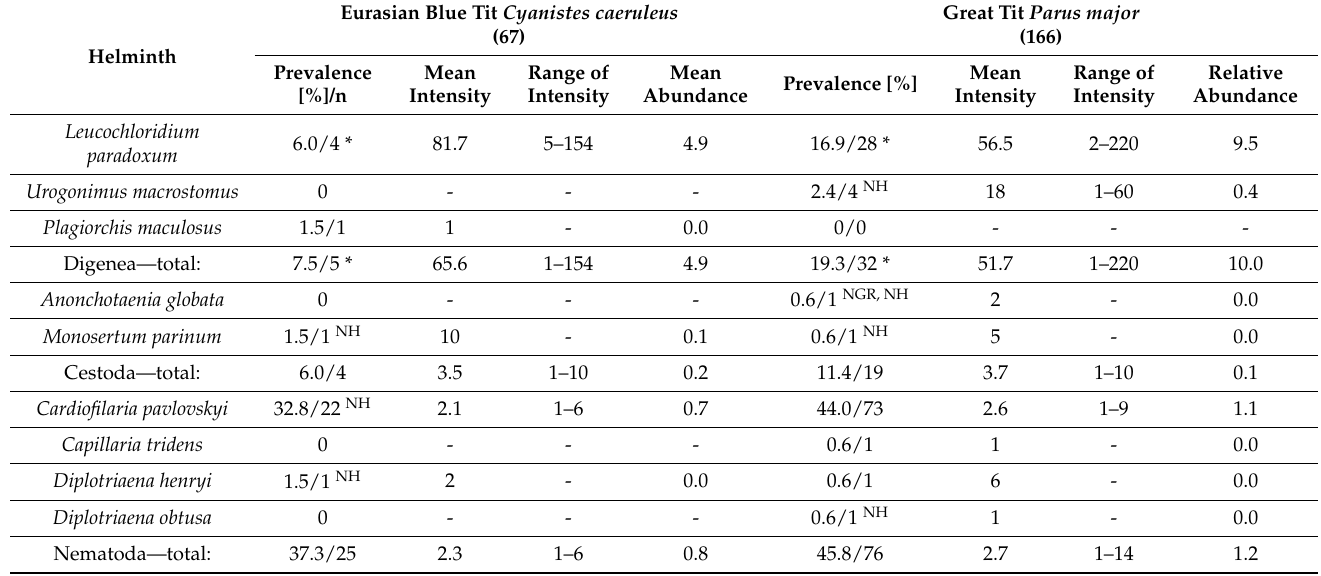
Table 1. Parasitological indicators of helminths in Eurasian blue tit and Great tit during autumn migration on the southern coast of the Baltic Sea, northern Poland, 2008–2012. Numbers of examined birds are given in brackets. Total values relate to the parasites identified up to the species level and individuals with no taxonomic assignment (details in the Materials and